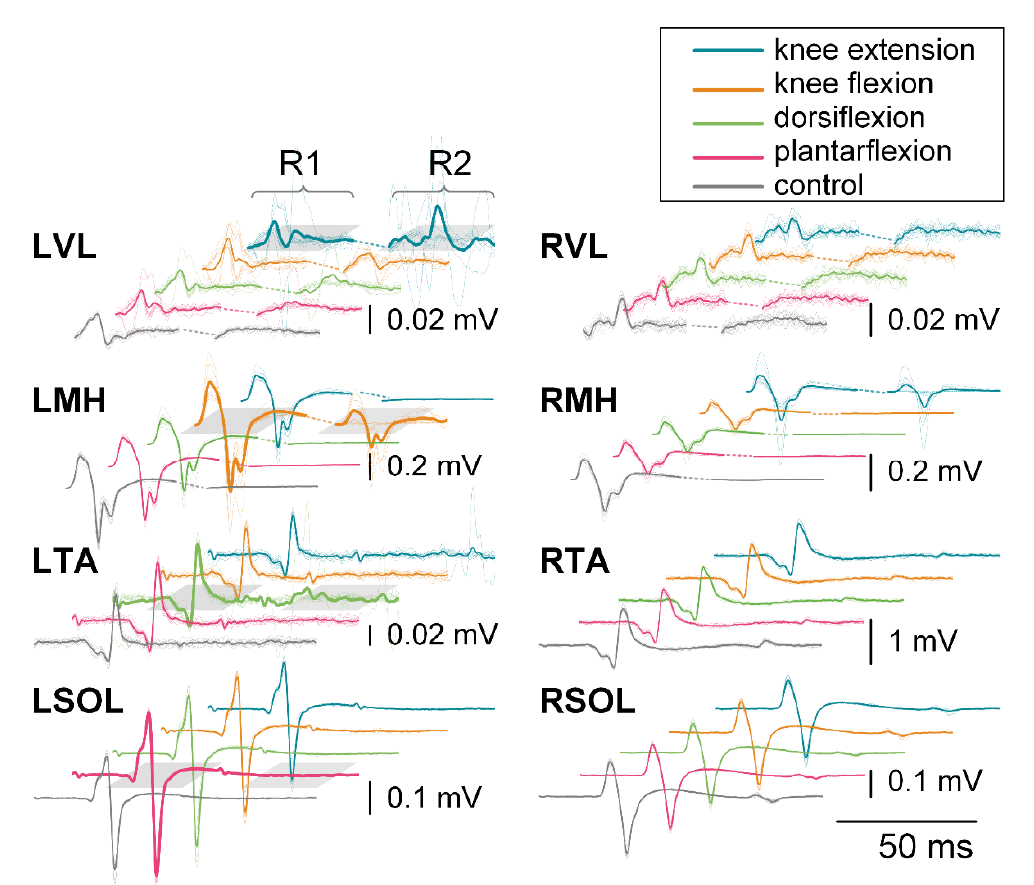
Figure 4. R1 and R2 responses for each muscle during knee extension (blue), knee flexion (orange), dorsiflexion (green), plantarflexion (pink), and control (gray) during the 200 ms CTI tactile condition for a representative participant. Individual responses are traces that are represented with a thin dotted line, while the average is shown with a thin solid line. The bold line signifies the agonist for that movement. Different scales are used for each muscle to better visualize the waveforms.